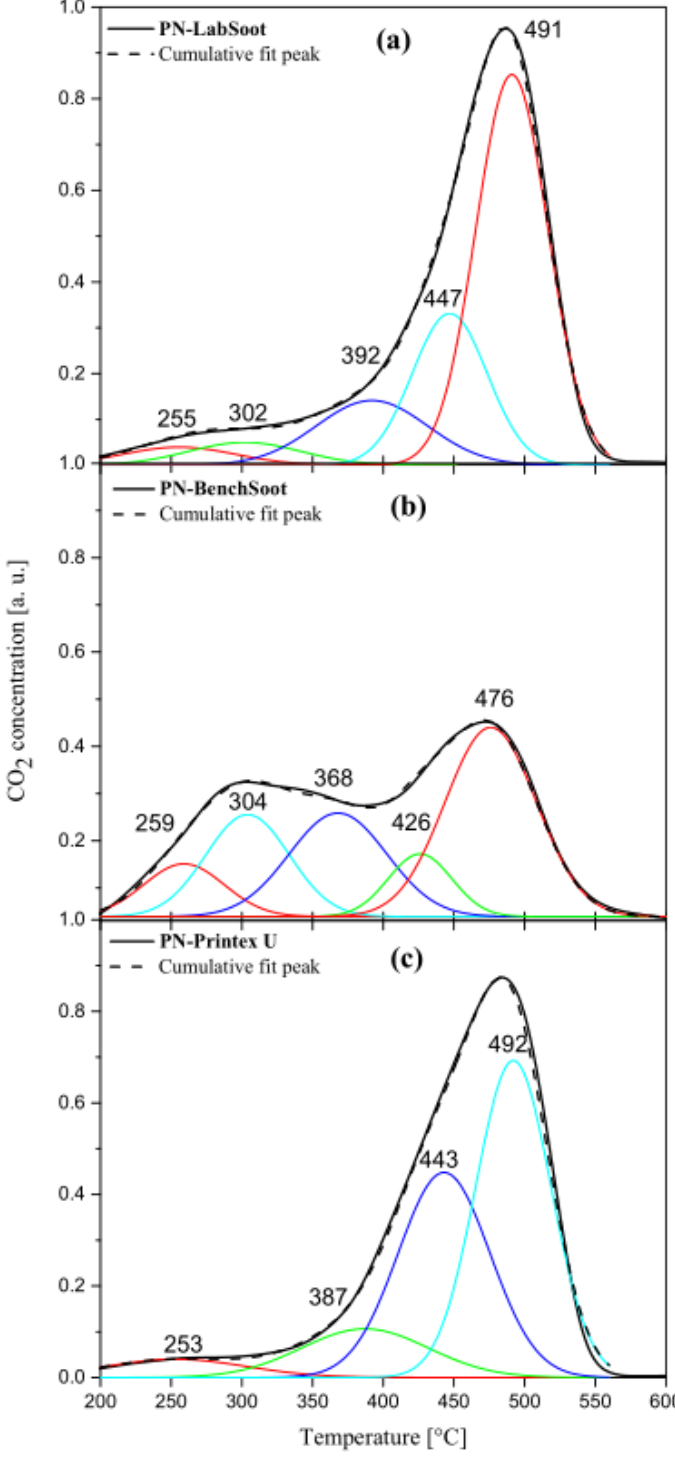
Figure 8. Deconvolution of TPO profiles for diesel-soot combustion: Catalytic activity of ceramic papers with binder: ( a ) PN-LabSoot, ( b ) PN-BenchSoot, and ( c ) PN-Printex U samples. Reactor inlet composition: 0.1% NO + 18% O 2 balance in He. The maxima of each deconvolution peak are indicated and the description is shown in Table 5.